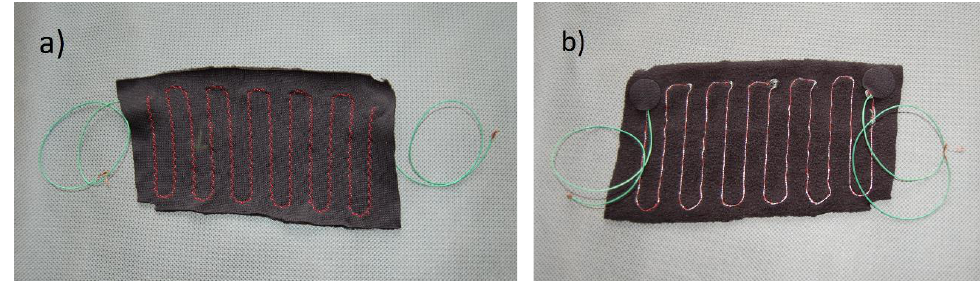
Figure 1. Photographs of the heating insert (variant A) — outer surface ( a ) and inner surface ( b ).